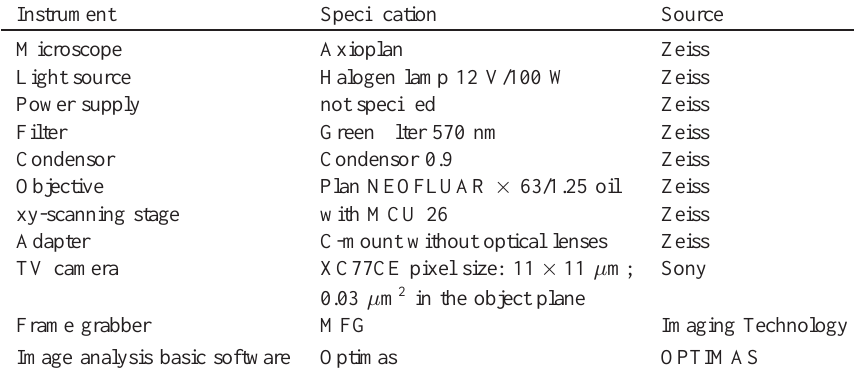
Table 2 Technical equipment for the image cytometry